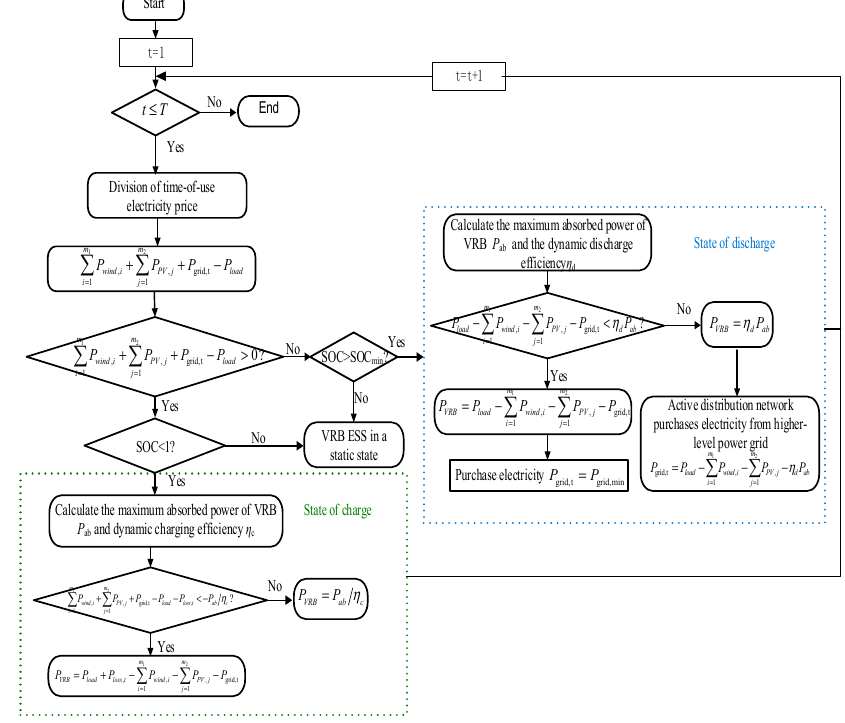
Figure 1. Energy storage of vanadium redox flow battery battery system operation strategy.